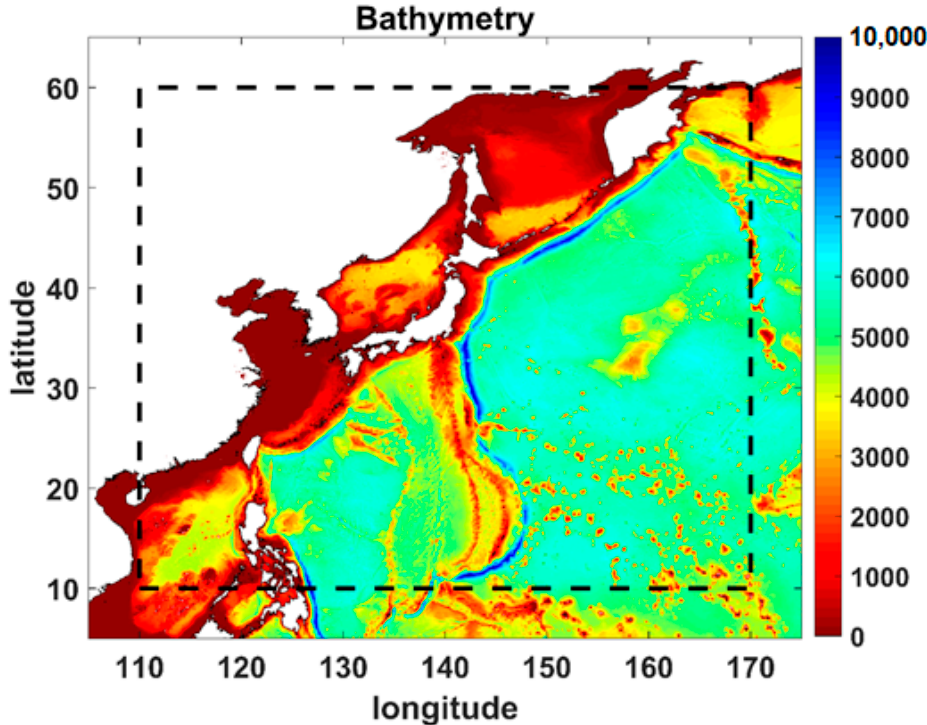
Figure 1. The western North Pacific (WNP) area as defined with a 5° enlarged domain. The bathymetry and shoreline over the WNP region are from the GEBCO_2019 grid and the GSHHG WNP region domain. In depth scale, 0 for the surface and 10,000 for the bottom.